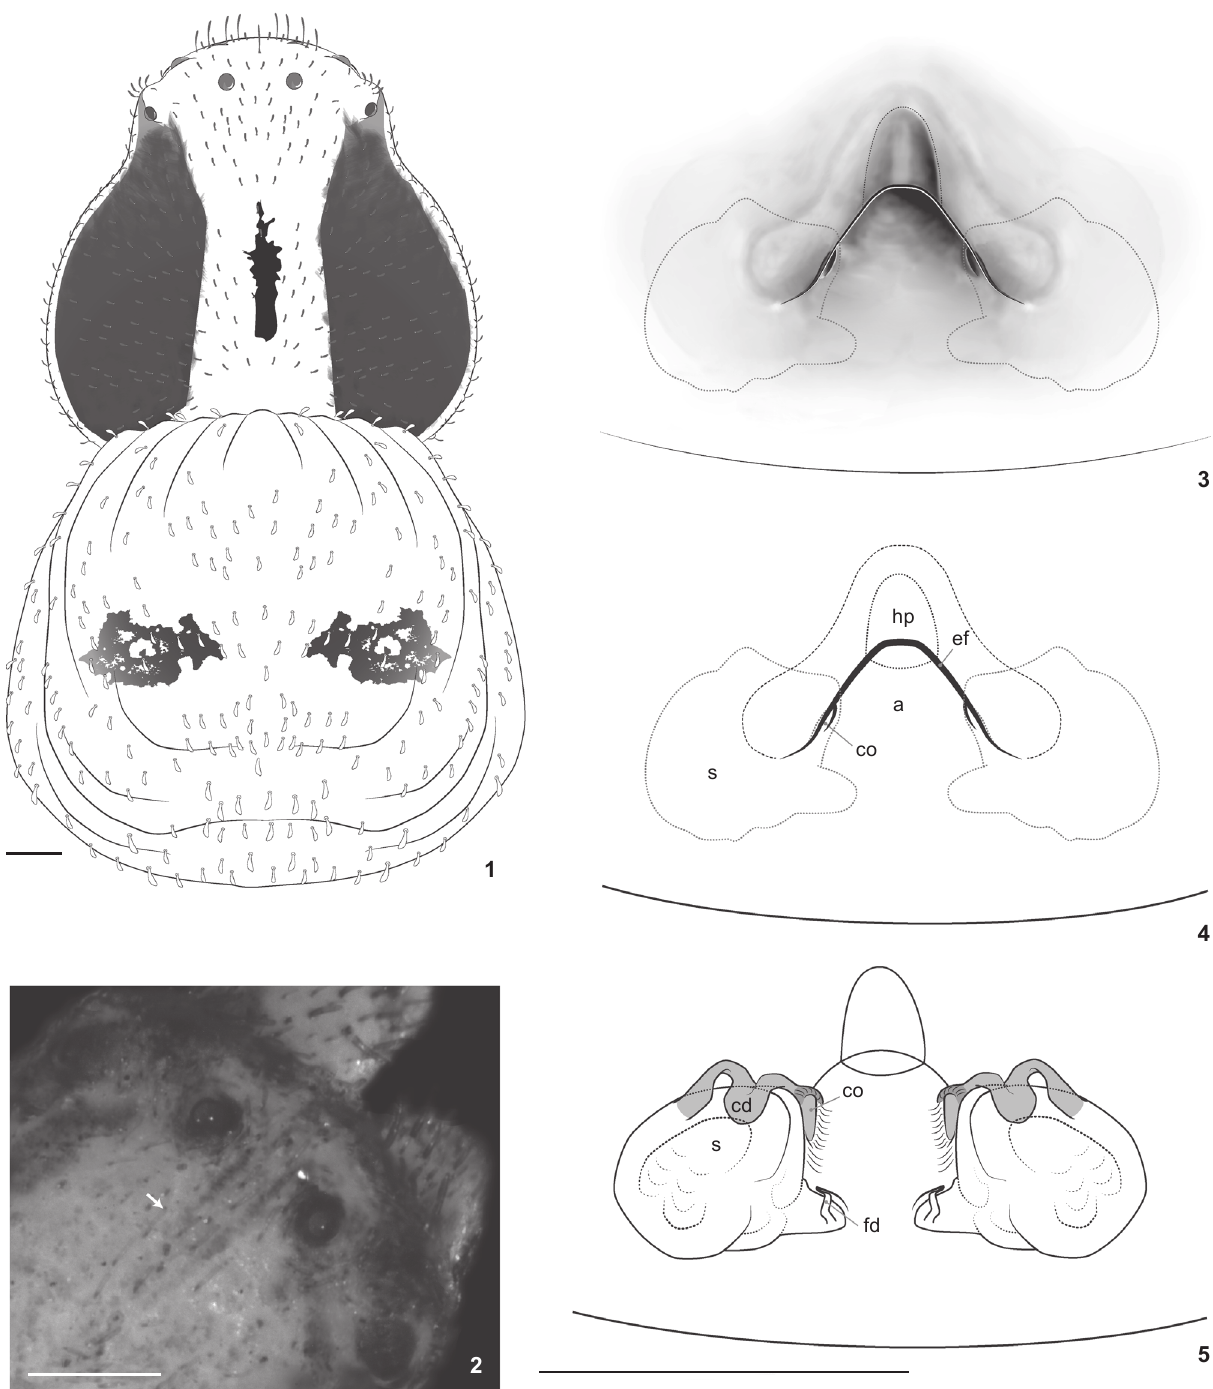
Figures 1-5. Misumenoides athleticus comb. nov. , female: (1) habitus, dorsal view; (2) detail of carapace showing spatulate setae, white arrow; (3) epigynum, ventral view; (4) outline of the epigynum, ventral view; (5) epigynum, dorsal view. Scale bar: 0.25 mm. (a) Atrium, (cd) copulatory duct, (co) copulatory opening, (ef) epigynal fold, (fd) fertilization duct, (hp) hood pocket, (s)